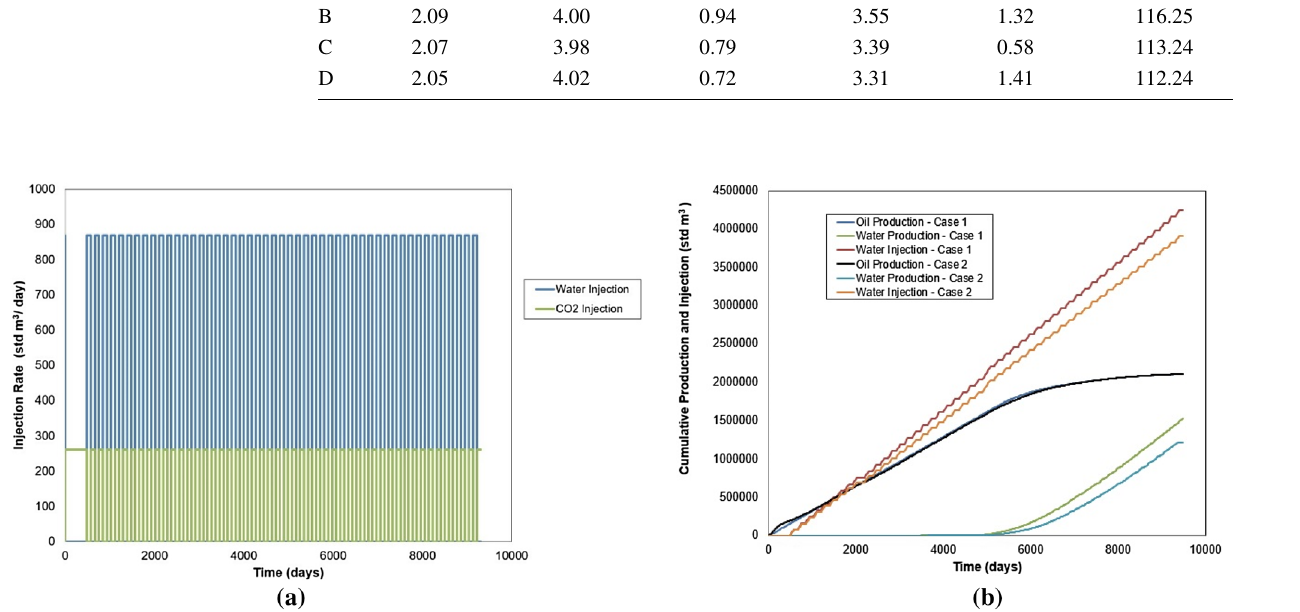
Fig. 5 Graphs of ( a ) water and CO 2 injection rate curves and ( b ) cumulative production and water injection for WAG recovery in case 2 in com- parison with case